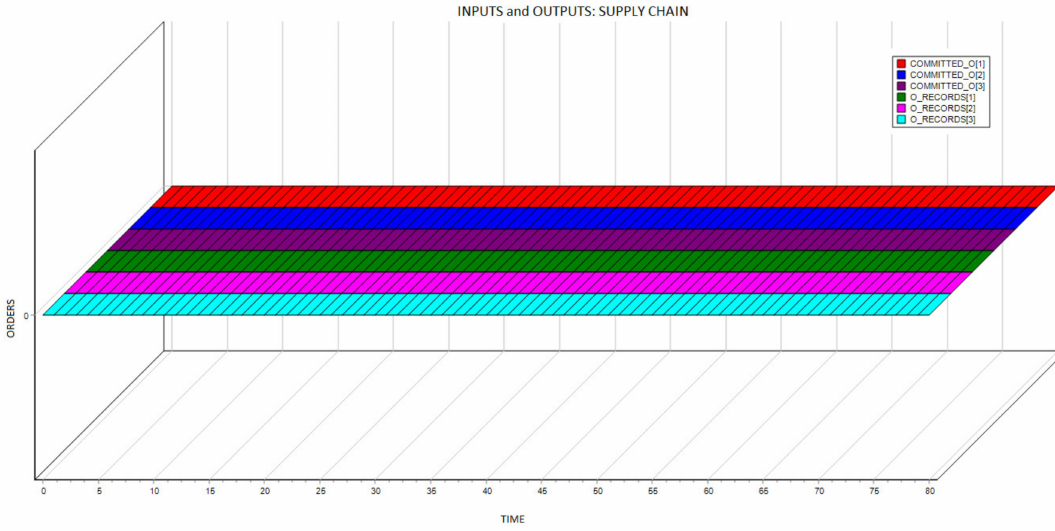
Figure 7. Extreme conditions test. Source: own elaboration. Evolution Software.